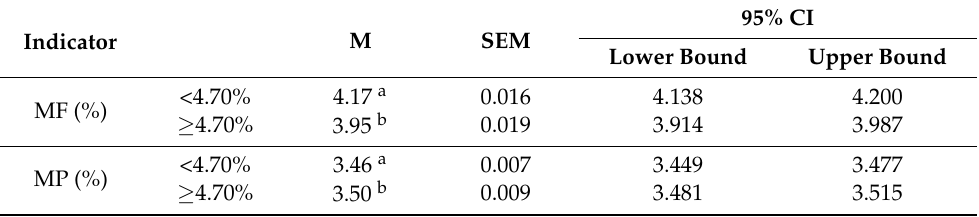
Table 2. Milk composition traits in cows by their lactose level in milk.